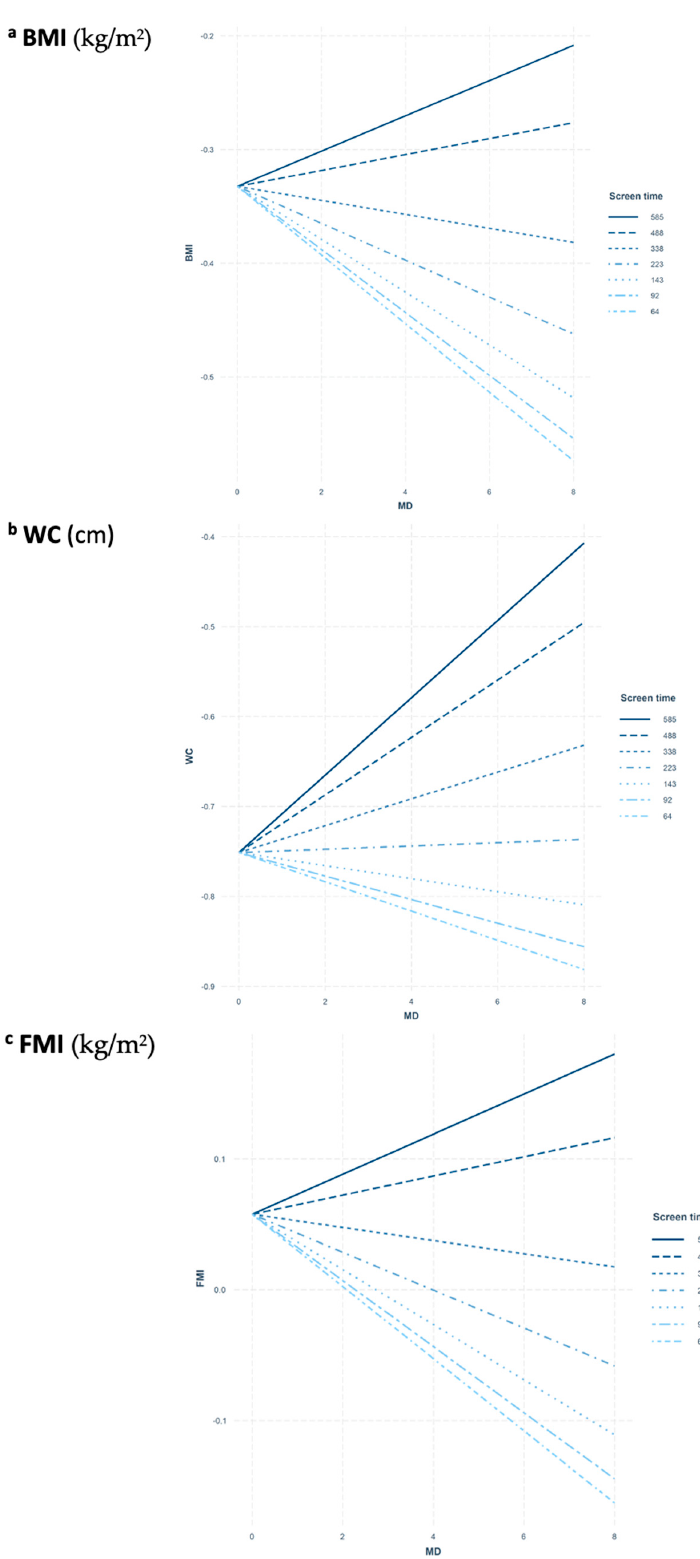
Figure 3. Matrix panel of interaction models on ( a ) BMI (body mass index), ( b ) WC (waist circumfer- ence), ( c ) FMI (fat mass index); and MD (Mediterranean diet) according to screen time modulation in females. In order to design the representation of the distribution in HELENA adolescents, different lines were traced as reference points to observe the slope of the studied population according to the sedentary time. A positive gradient represents the MD acting as risk factor, while a negative gradient shows the MD acting as protective factor.